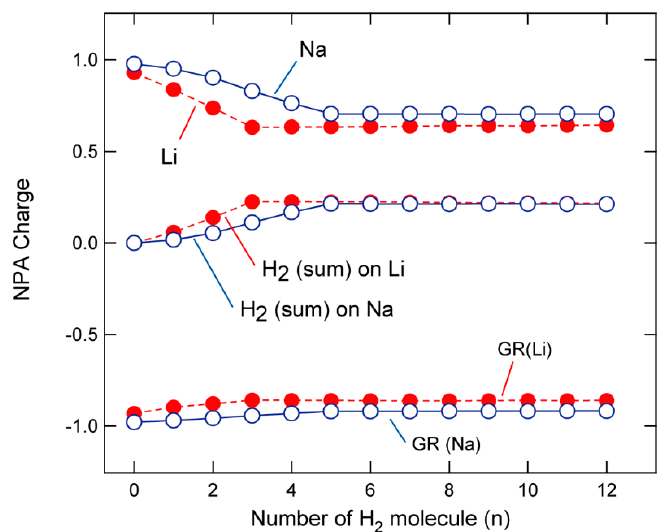
Figure 4. NPA-determined atomic charges of Li, Na, and GR as functions of n . Summed H 2 charges are also plotted. Calculations were performed at the CAM-B3LYP/6-311G(d,p) level. Distance ( h ) between Na and the GR surface are plotted in Figure 5 as functions of n ; h was observed to increase with increasing n for both Na and Na + to the second shell ( n = 5) and became saturated at 2.35 Å (Na) and 2.42 Å (Na + ). For lithium, the saturated distances were determined to be 1.85 Å (Li) and 1.89 Å (Li + ) (from n = 5).